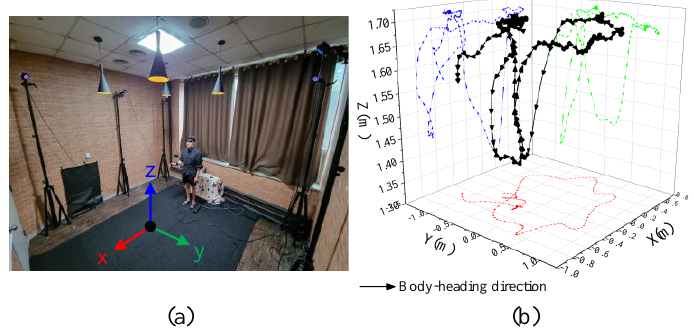
Figure 7. ( a ) Experimental environment including Optitrack’s six prime -13 vision sensors and Xsens wearable IMU sensors, and changes in ( b ) pose and body − heading direction of subjects in the data acquisitions.